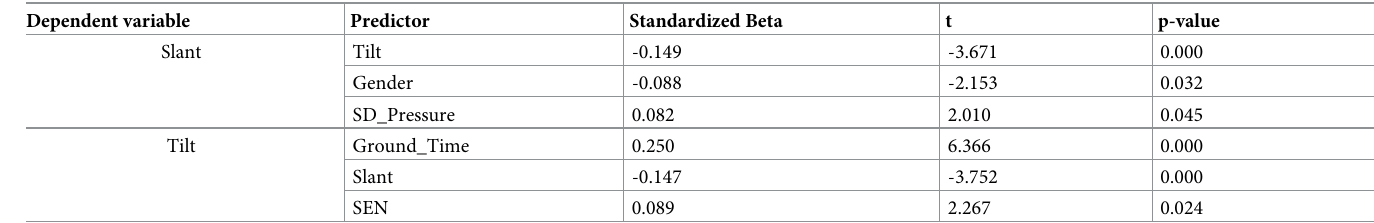
Table 7. Regression model of students’ Chinese handwriting slant/tilt degree and other